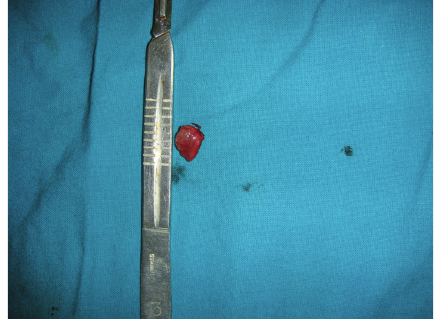
Figure 4: Excised tissue.